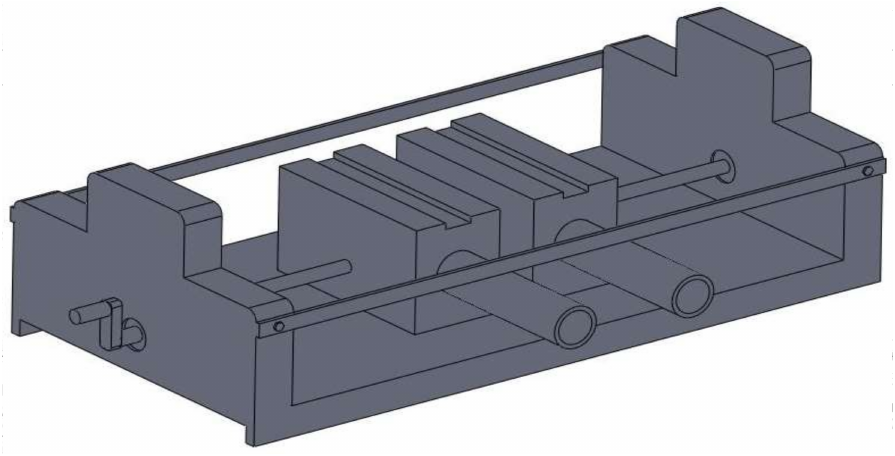
Figure 2. Isometric view of twin jet impingement mechanism